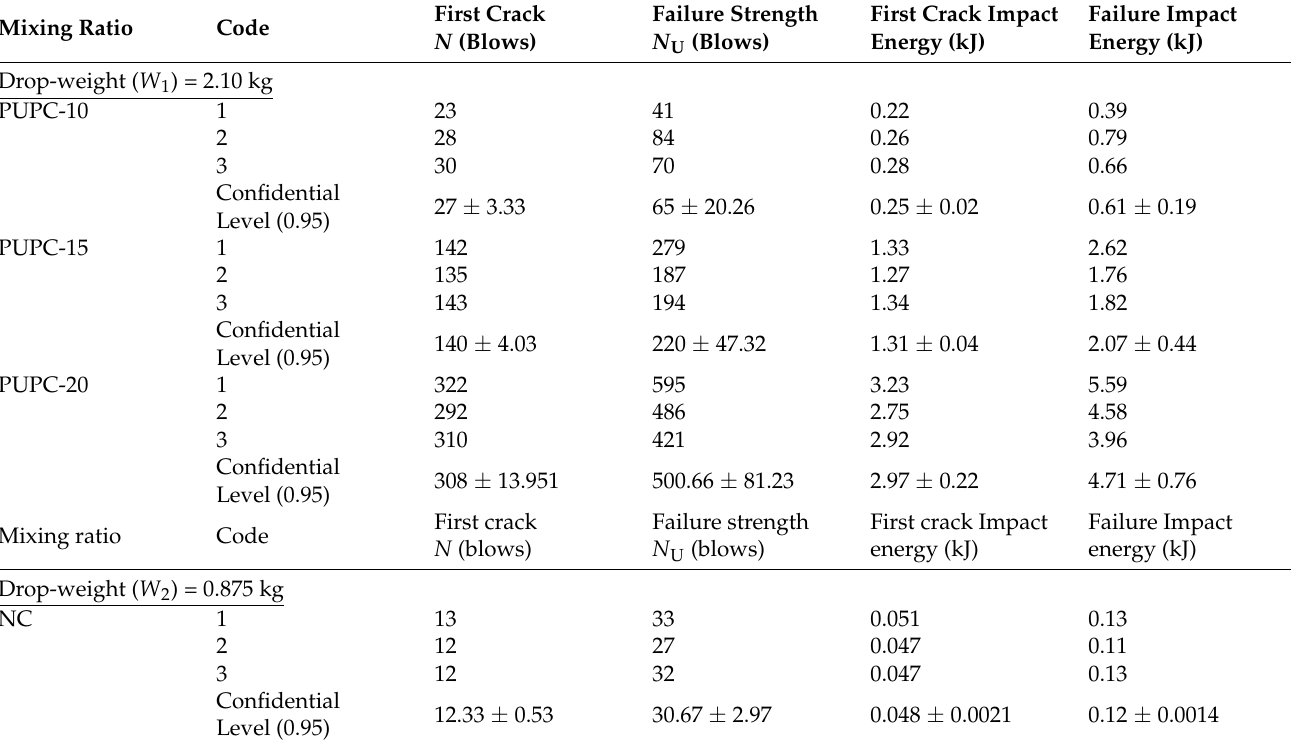
Table 2. Impact resistance of the U-shaped polymer and normal concrete